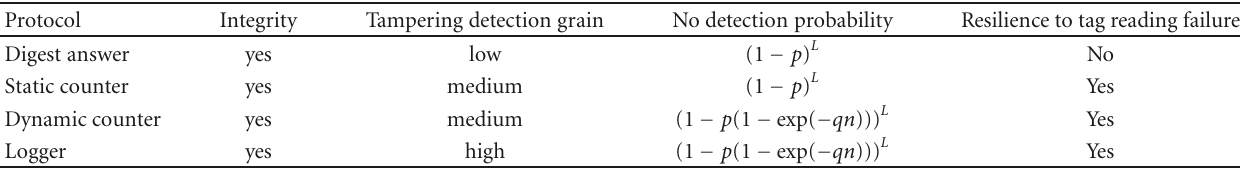
Table 2: Protocols comparison: properties.